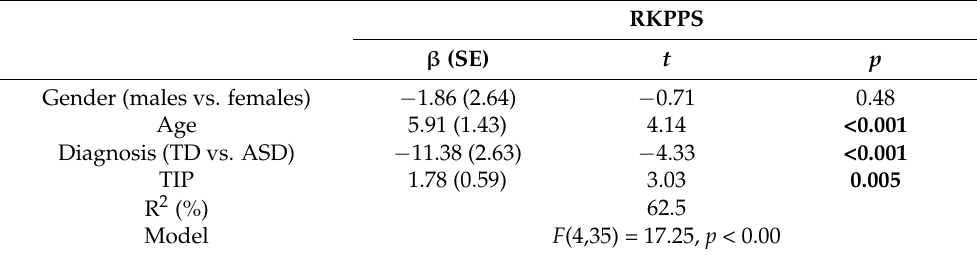
Table 5. Regression analysis of the TIP and demographic variables on the RKPPS. RKPPS β (SE) p Gender (males vs. females) − 1.86 (2.64) Diagnosis (TD vs.